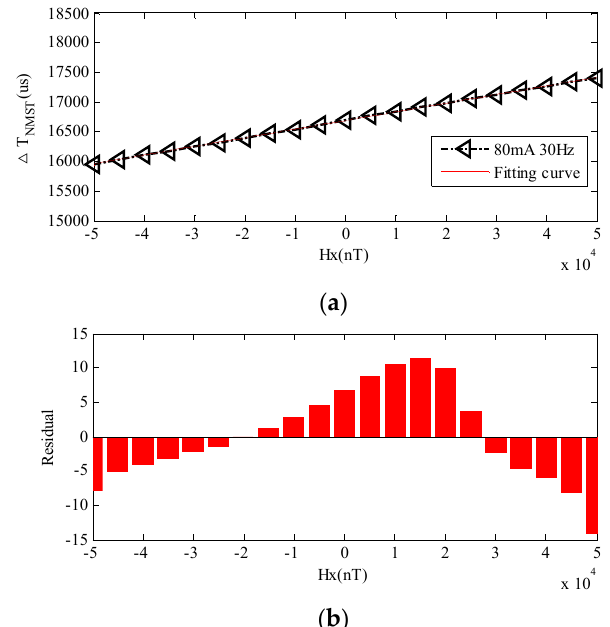
Figure 11. Fitting linearity deviations of Δ T NMST 1 with I 1 = 80 mA and f = 30 Hz. ( a ) Fitting curve of Δ T NMST 1 ; ( b ) Deviations of Δ T NMST 1 .